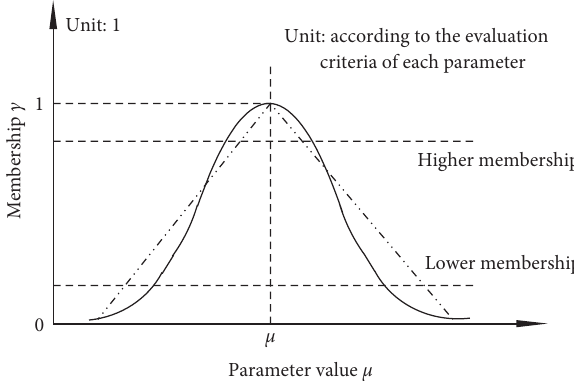
Figure 1: Comparison of membership in normal and triangular